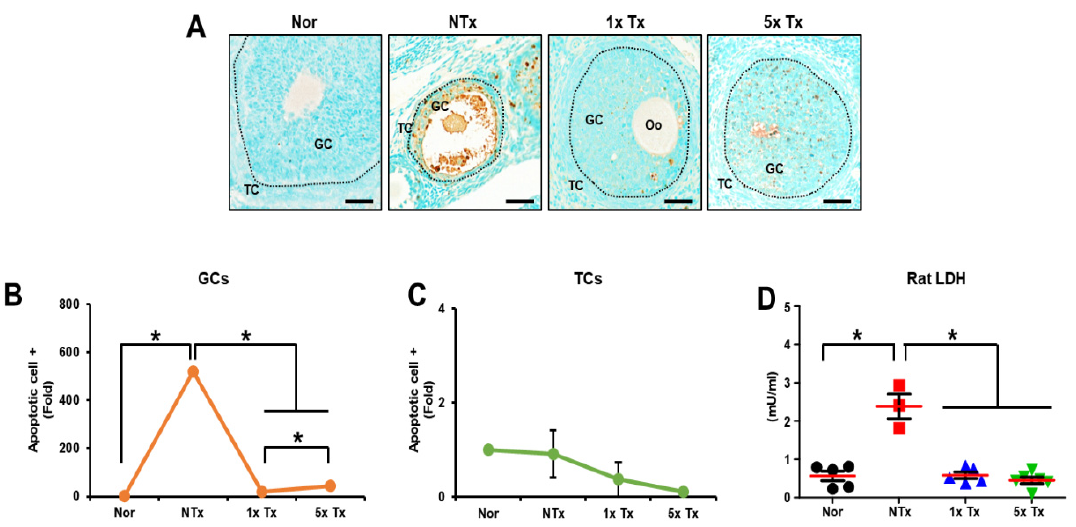
Figure 2. Effect of a low dose of PD ‐ MSCs on apoptosis in the ovaries of rats with ovarian dys ‐ function. ( A ) The apoptotic cells of follicles were stained with a TUNEL assay kit. Scale bar: 100 μ m, Magnification: 20X. ( B ) Apoptosis in granulosa cells (GCs) and ( C ) theca cells (TCs) of mature follicles (e.g., secondary, antral follicles) was quantified by means of the 3D HISTECT program. ( D ) The concentrations of LDH in individual serum samples were analyzed by ELISA. GC: granulosa cell, TC: theca cell, Oo: oocyte. The data are representative of three independent experiments and expressed as the mean ± S.D. Statistical significance was determined by using one ‐ way ANOVA, * p < 0.05.